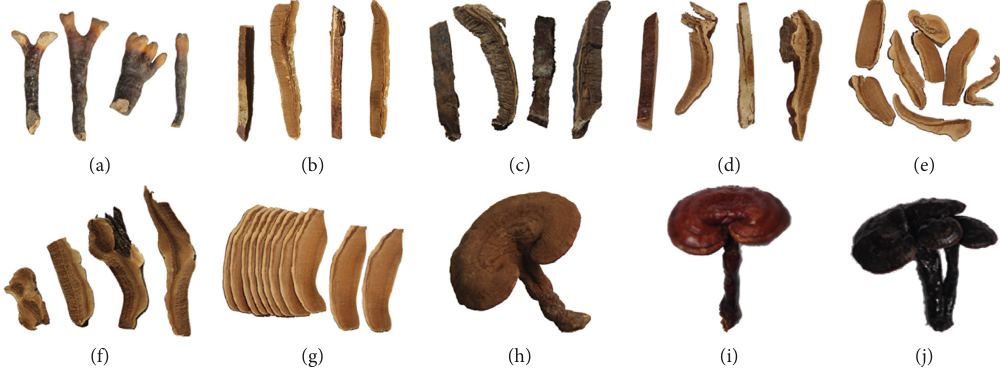
Figure 1: Different origins of Ganoderma : (a) Anhui: (b) Anhui: (c) America: (d) Anhui: (e) Jilin: (f) Anhui: (g) Anhui: (h) Henan: (i) Anhui: (j)